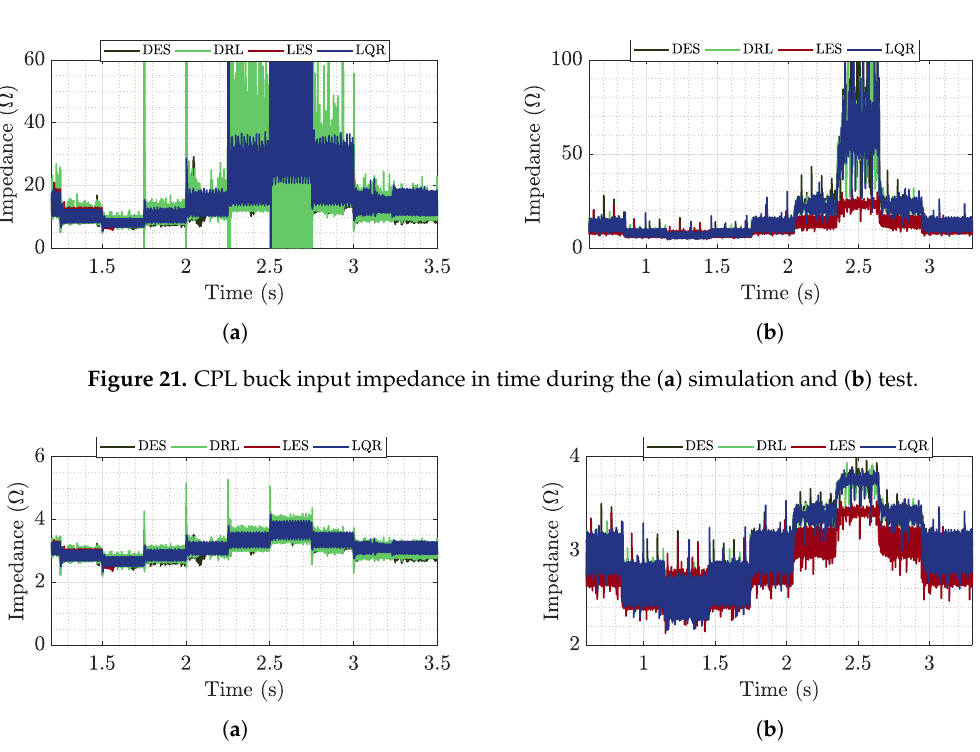
Figure 22. Feeder buck output impedance in time during the ( a ) simulation and ( b )